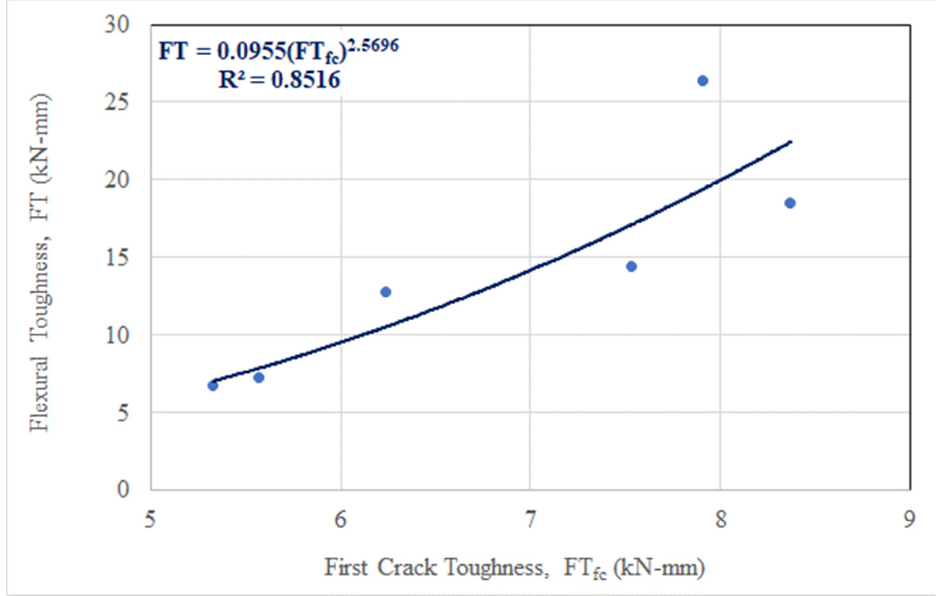
Figure 10. Correlation between First-Crack Toughness and Flexural Toughness.